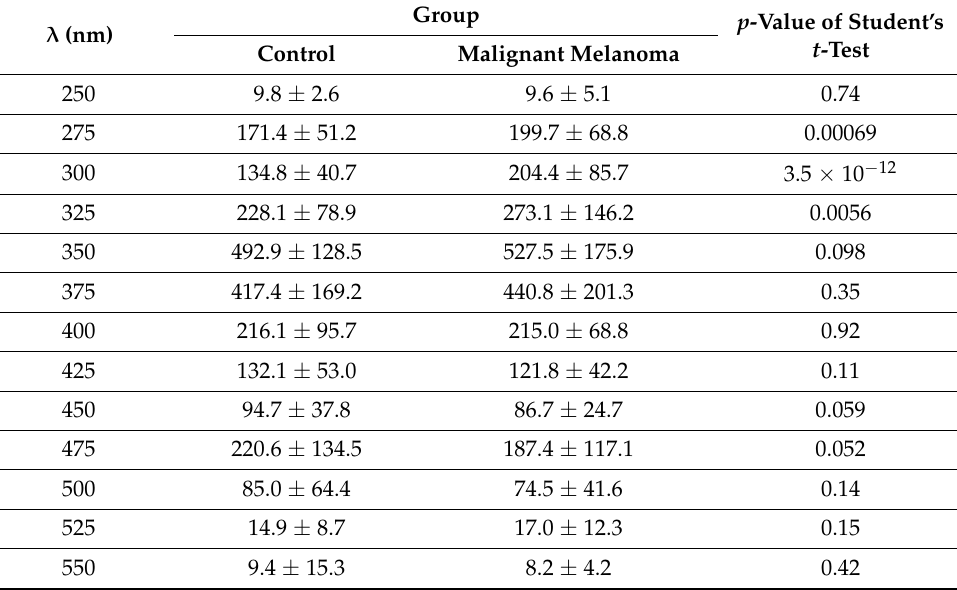
Figure 2. Fluorescence intensities of the control and malignant melanoma groups at 295 nm and 455 nm. Statistically significant differences are related to the control group. Values are expressed as mean ± SD. * indicates p < 0.05 and *** indicates p < 0.001. Table 1. Comparison of fluorescence intensity at various wavelengths through whole measured spectrum (in 25 nm steps) in healthy and control group. For evaluation of differences, Student’s t - test was used. Values of fluorescence intensity are expressed as mean ± SD.